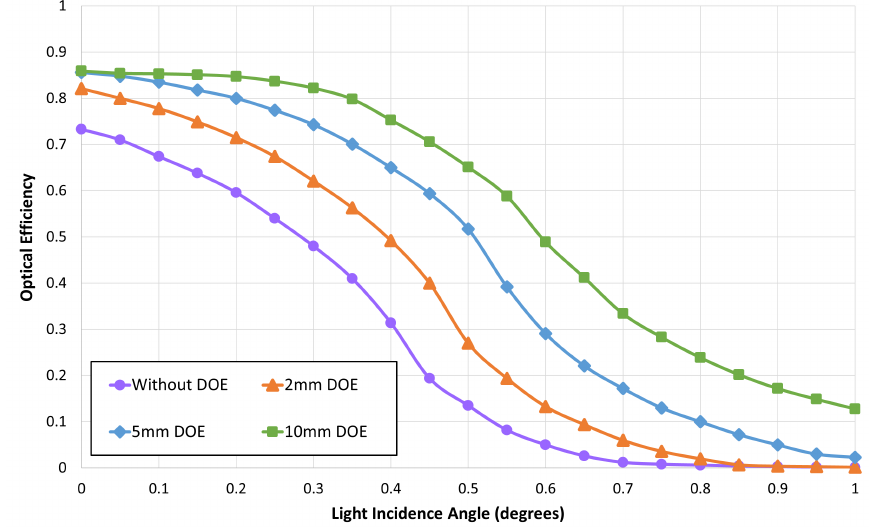
Figure 4. Angular efficiency curves for the different optical configurations studied, with 2 mm misalignment between the Fresnel lens and the diffractive